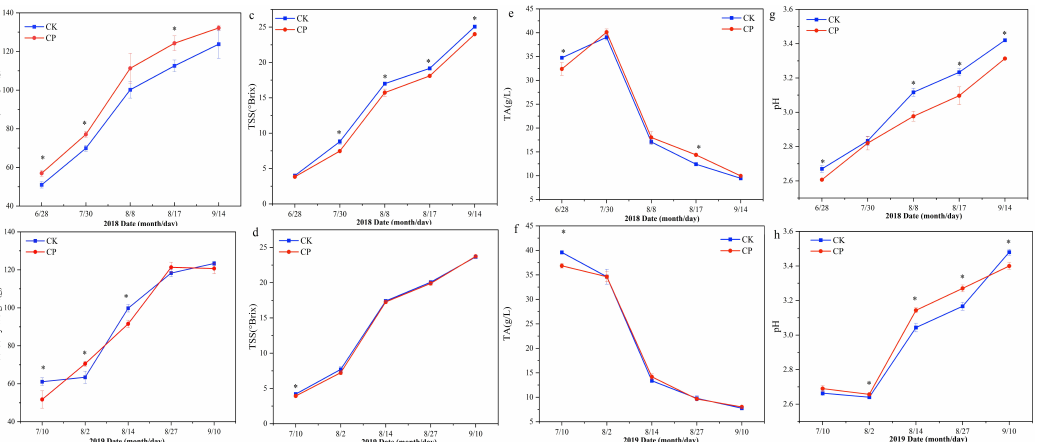
Figure 3. Berry physicochemical parameters of clean tillage (CK) and covering purslane (CP) of ‘Cabernet Sauvignon’ grapes. ( a ) 100-berry weight in 2018; ( b ) 100-berry weight in 2019; ( c ) total soluble solids in 2018; ( d ) total soluble solids in 2019; ( e ) titratable acidity in 2018; ( f ) titratable acidity in 2019; ( g ) pH value in 2018; ( h ) pH value in 2019. * indicates significant differences between the control and covering purslane ( p < 0.05, t -test).